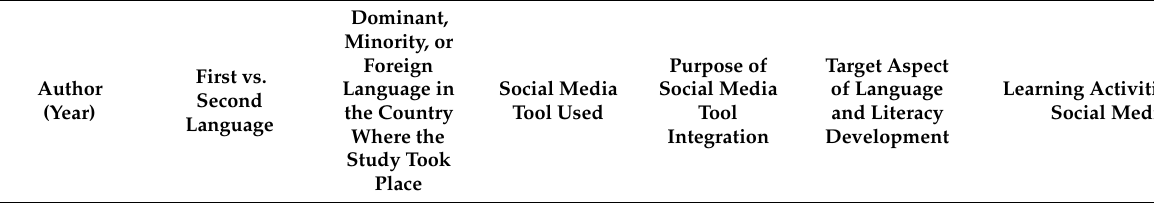
Table 4. Application of social media tools in language and literacy